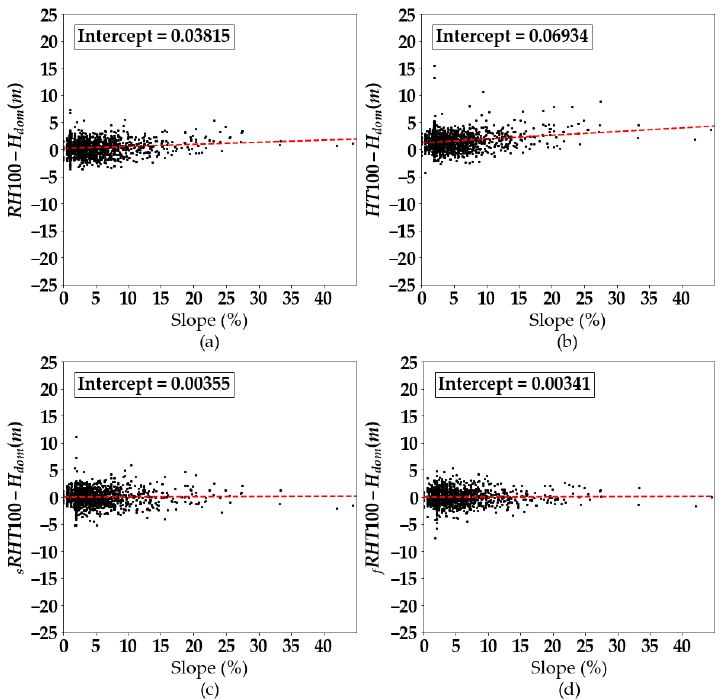
Figure 11. ( a – d ) Distribution of several GEDI metric height errors by slope gradient.